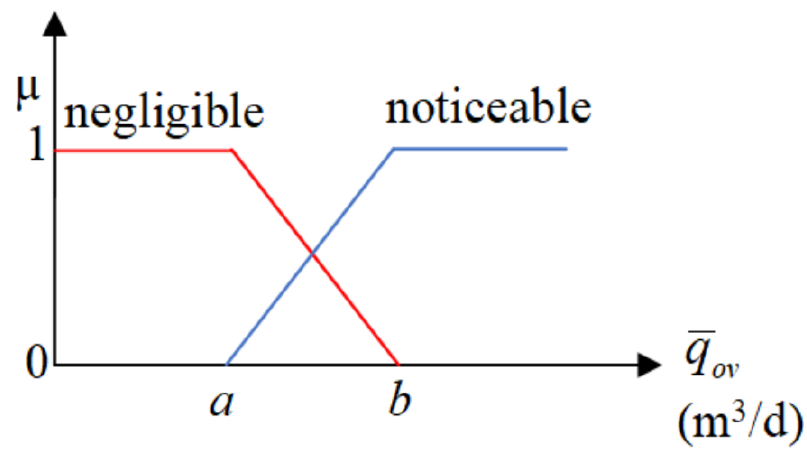
Figure 8. Fuzzy sets for q